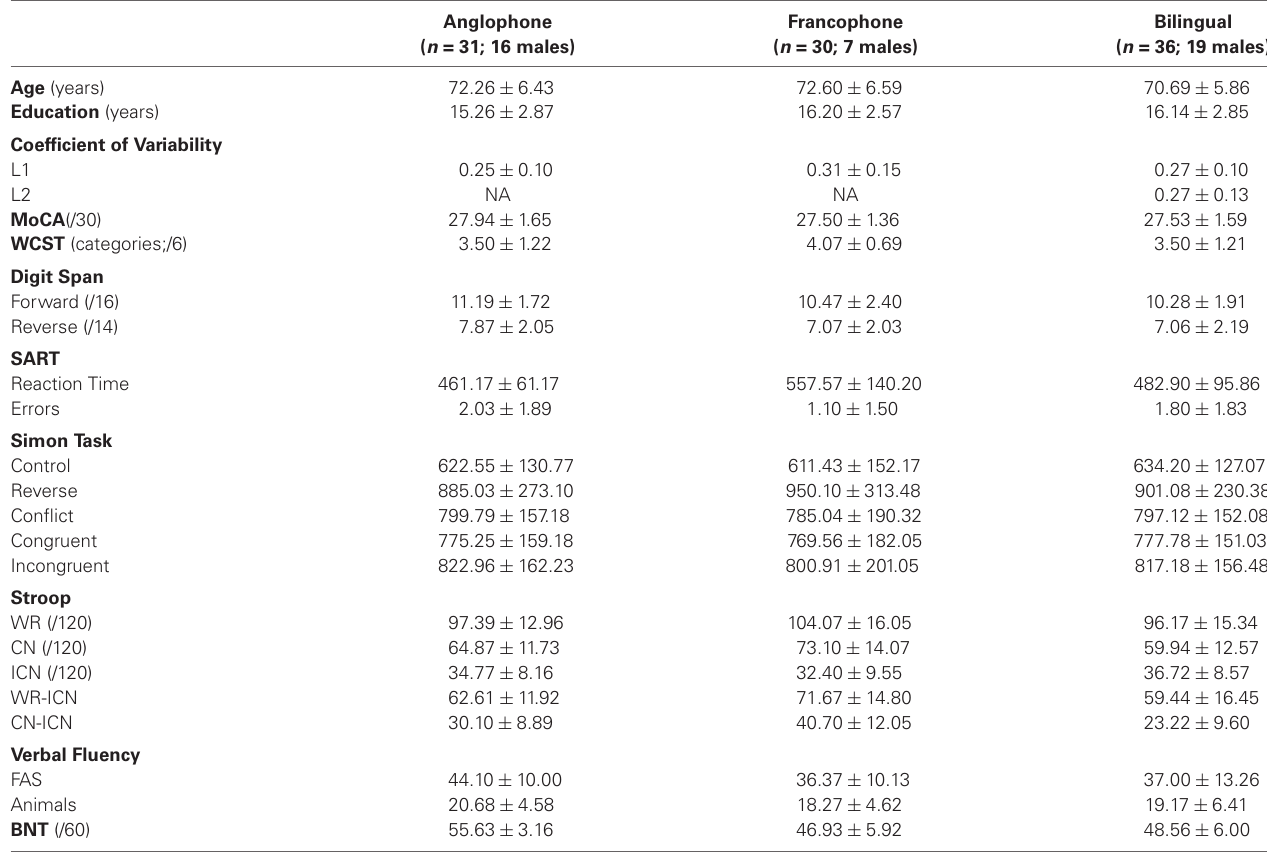
Table 3 | Older adult demographic, neuropsychological, executive function, and language task performance (mean ± standard deviation)